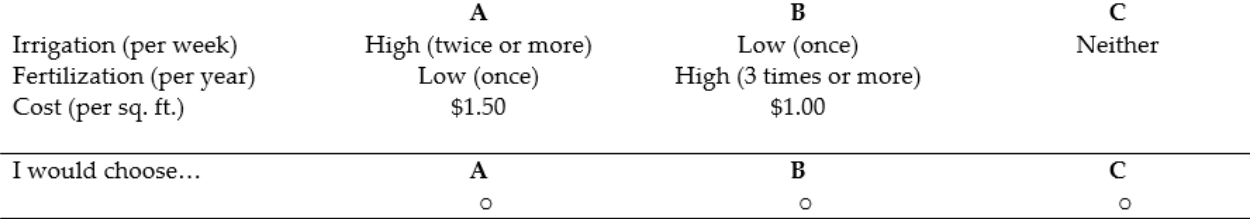
Figure 1. Example of one of the choice scenarios the participant viewed and selected from.